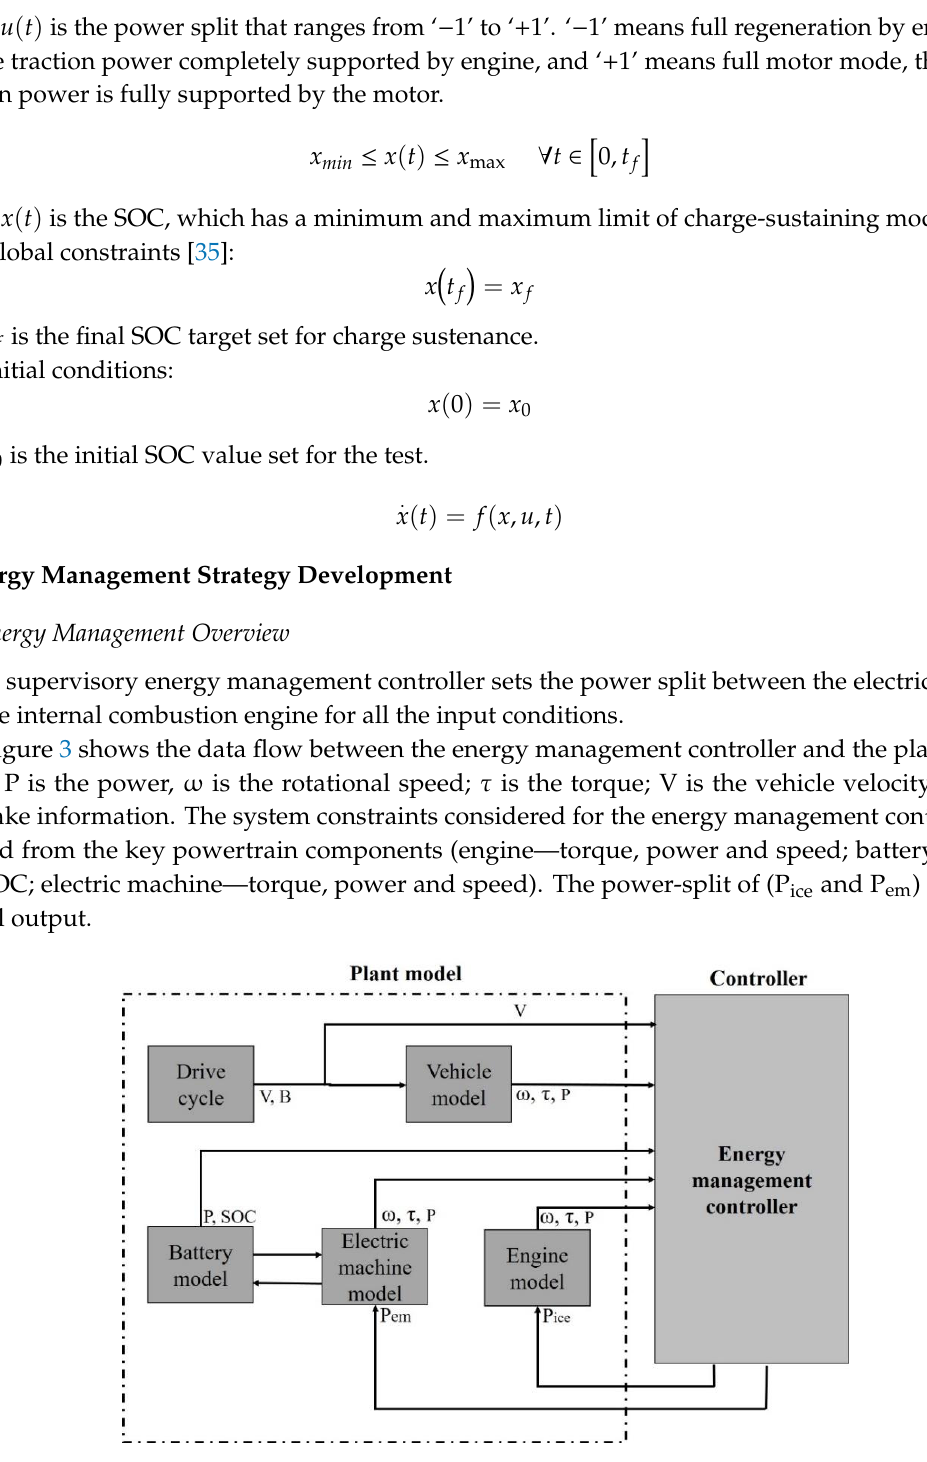
Figure 3. Control data flow block.